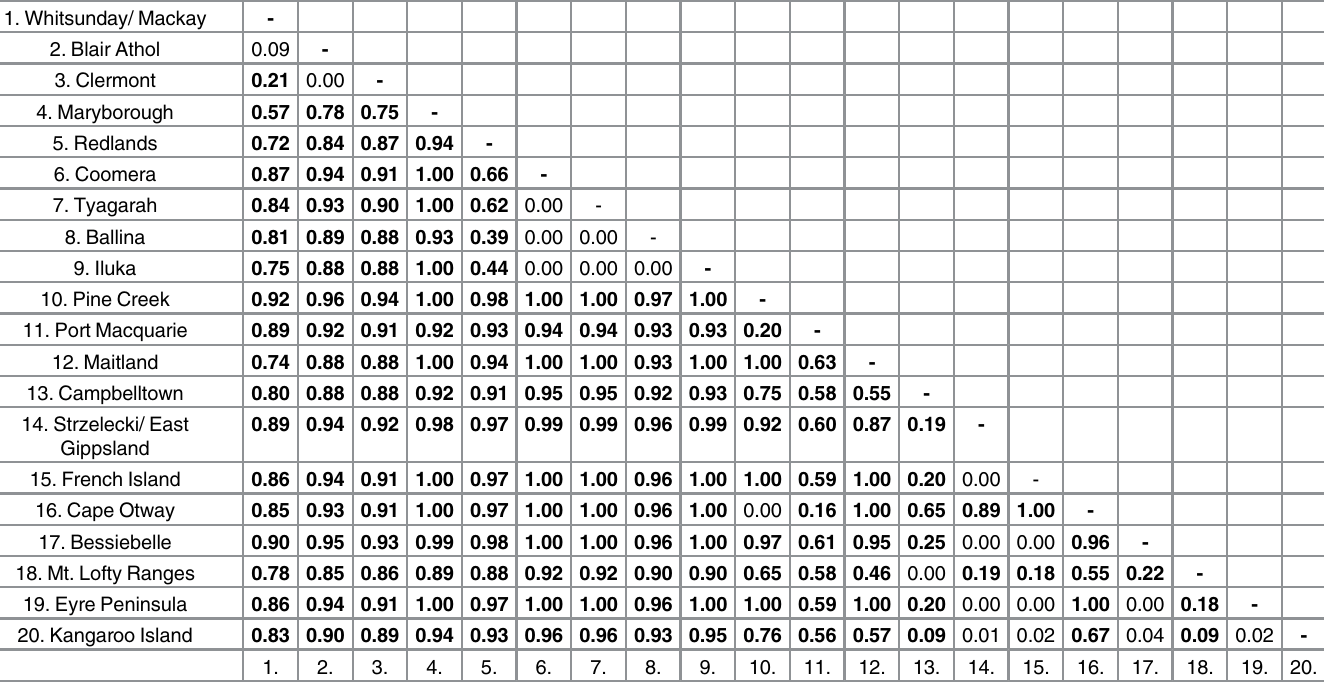
Table 3. Levels of differentiation ( Φ ST) between samples localities (n > 7) of